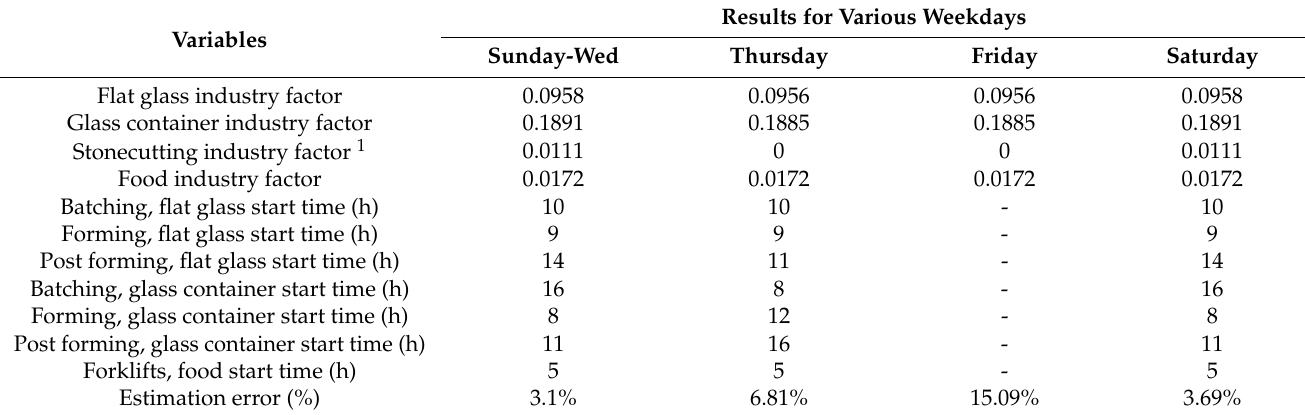
Table 16. The optimum value of the variables for various weekdays in a fall week.